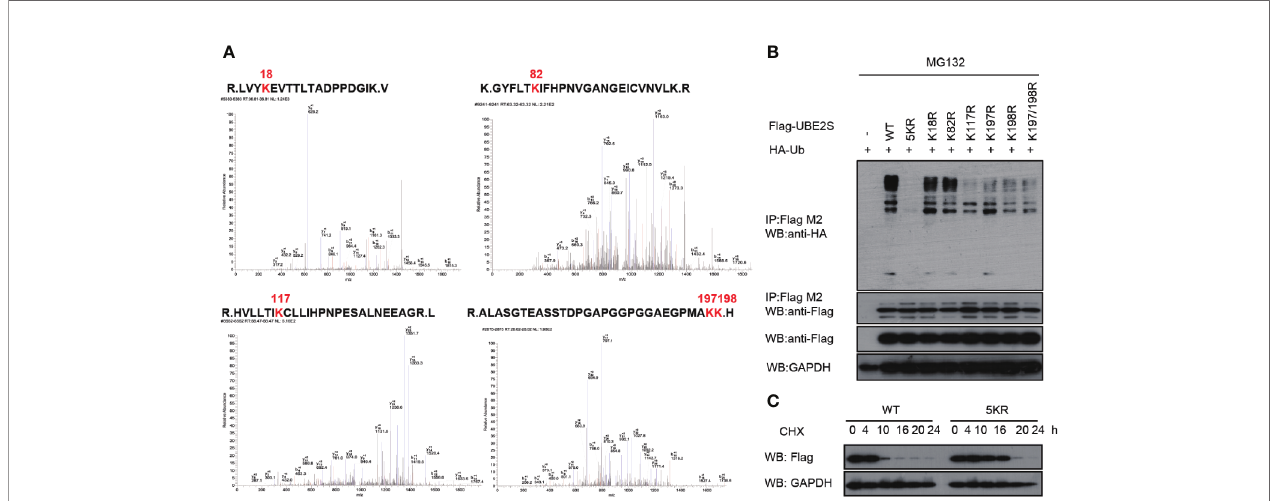
FIGURE 6 | Validation of ubiquitination sites of UBE2S. (A) Identi fi cation of ubiquitination sites of UBE2S by Mass Spectrometry . (B) U87 cells were transfected with indicated plasmids and treated with 100 nM CHX for four hours before harvest. Representative pictures of whole-cell lysates and immunoprecipitants as analyzed by Western blotting using the indicated antibodies. Experiments were performed in triplicates. (C) U87 cells were transfected with indicated plasmids and treated with 100 nM CHX at different times as indicated. Representative pictures of UBE2S protein levels as analyzed by Western blotting. Experiments were performed in